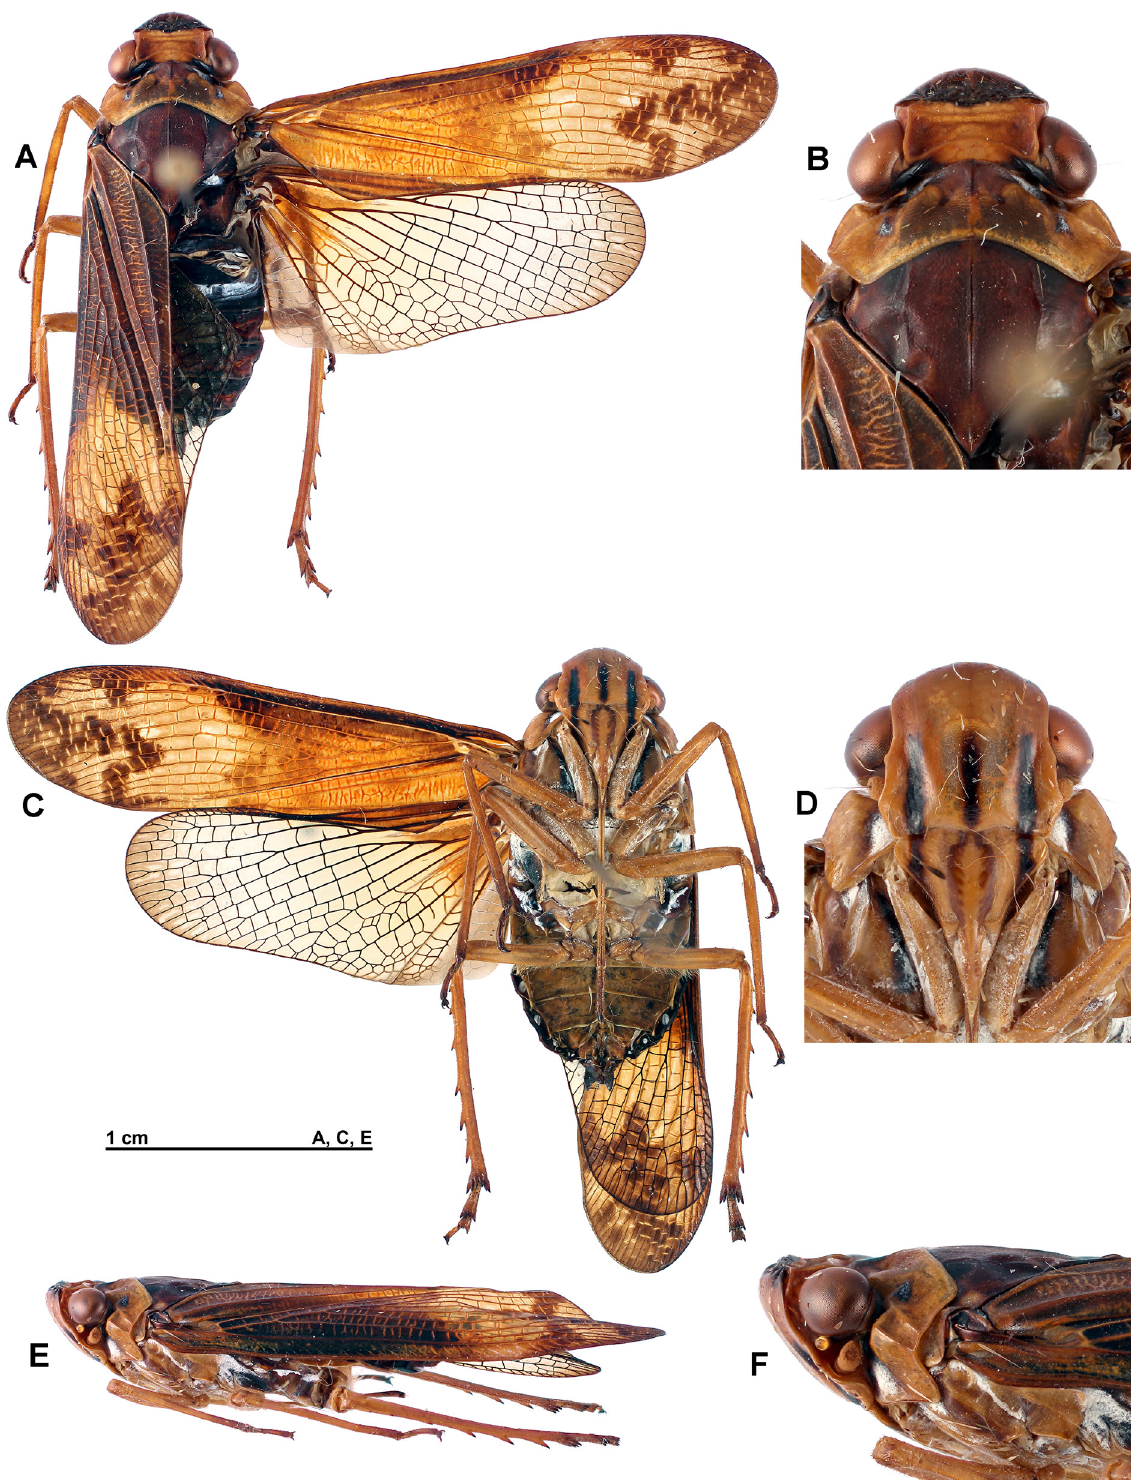
Fig. 8. Birdantis trilineata (Schmidt, 1926), ♀, Boano Island. A . Habitus, dorsal view. B . Head and thorax, dorsal view. C . Habitus, ventral view. D . Head, normal view of frons. E . Habitus, lateral view. F . Head and thorax, lateral view. B, D, F not to